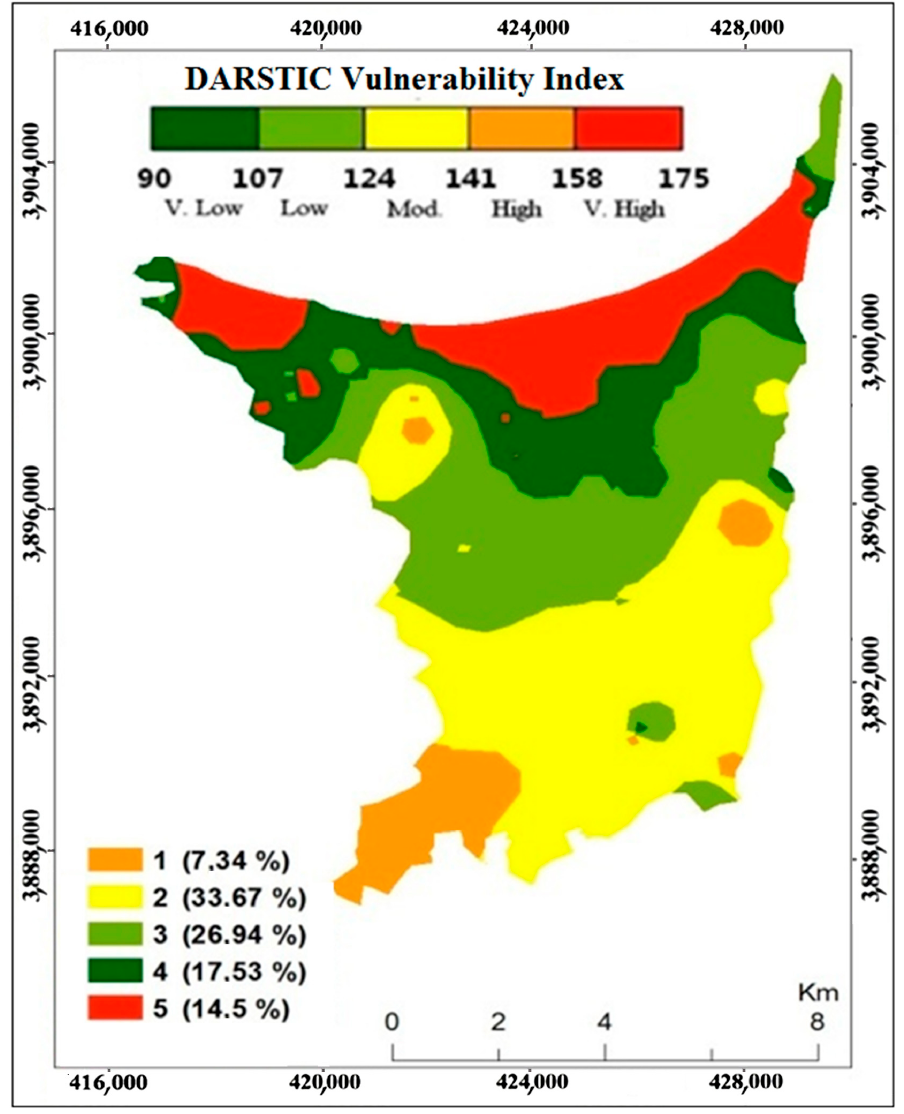
Figure 5. DRASTIC vulnerability index map.